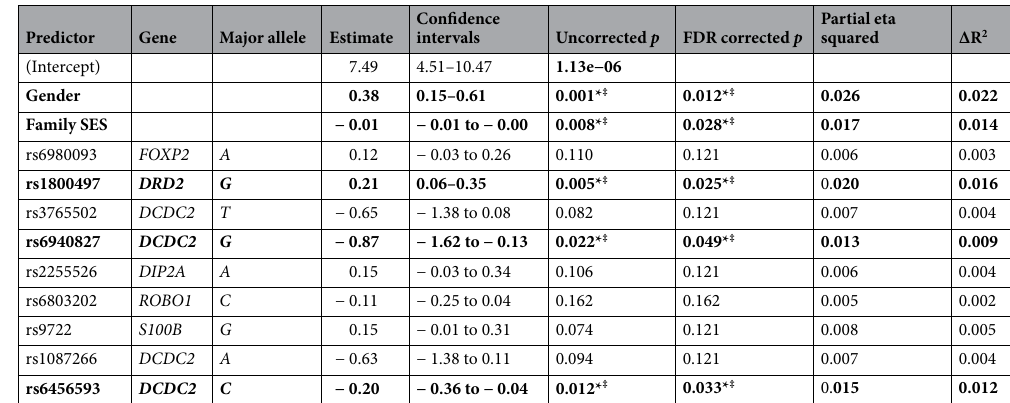
Table 3. The final model of bi-directional stepwise regression analyses for L1 proficiency using the original dataset. Gender, family SES, and three SNPs (rs1800497, rs6940827, rs6456593) are independently associated with L1 HKDSE grades. The original model included gender (Female = 1; Male = 0), music training (Yes = 1; No = 0), family SES, and the 28 hypothesized SNPs. * indicates p < 0.05 (uncorrected); ‡ represents significant associations after FDR corrections for multiple comparisons. Observations: 421. R 2 /R 2 adjusted: 0.119/0.096, p = 2.215e−07. Significant values are in bold.